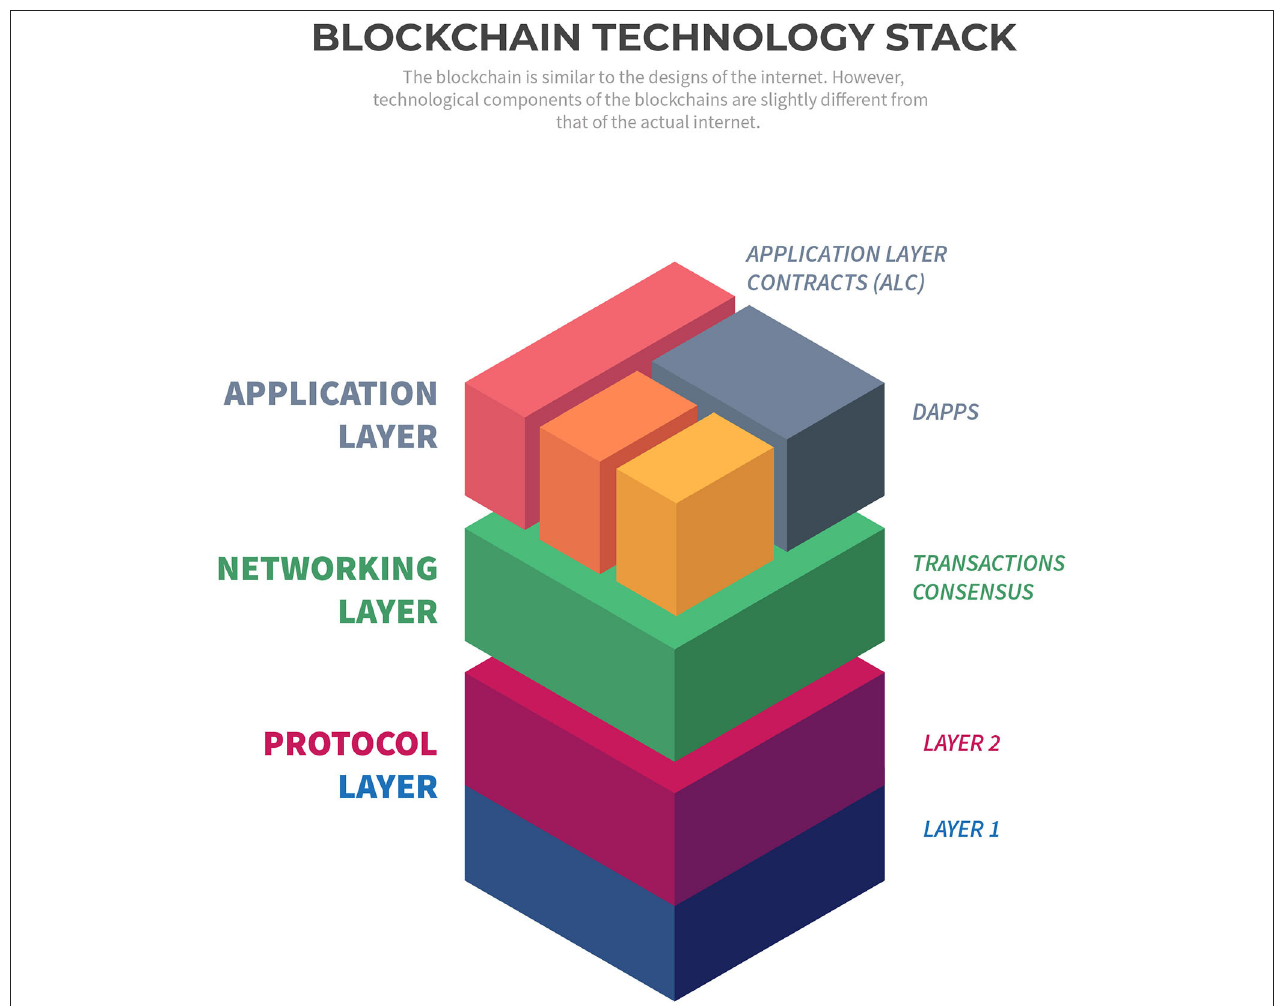
FIGURE 2 | Blockchain technology